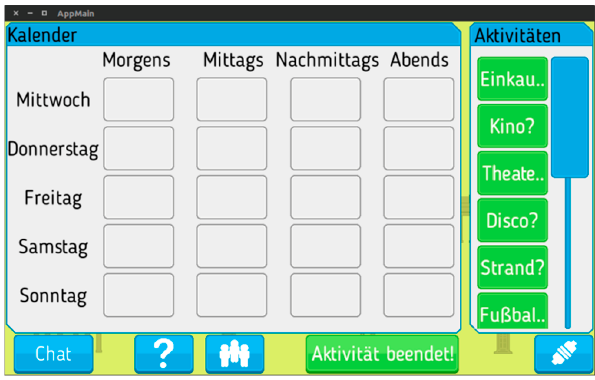
Figure 3. Personal student agenda in its digital version.